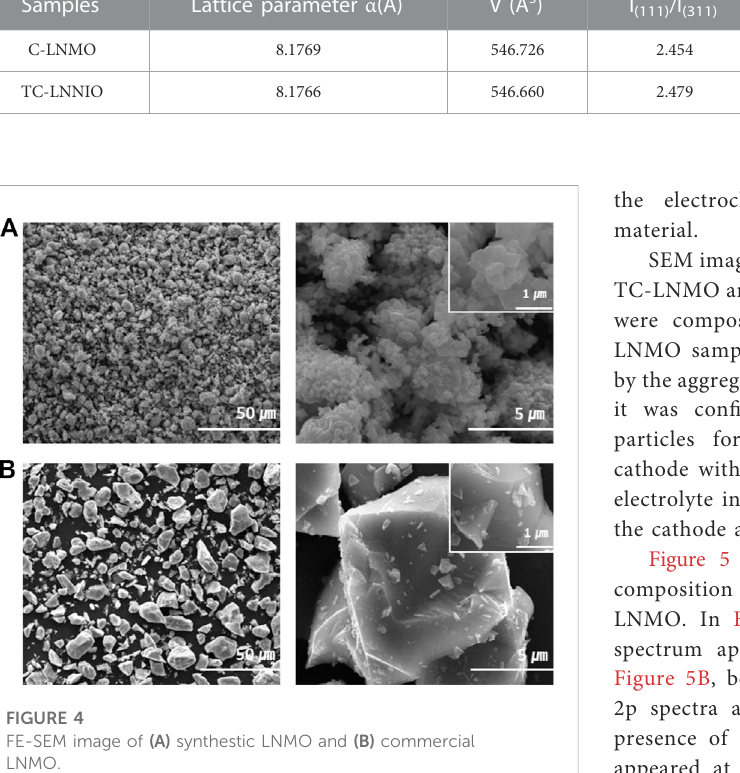
TABLE 1 Lattice parameters of LNMO samples obtained through Rietveld-re fi nement and surface area values obtained through BET. Samples